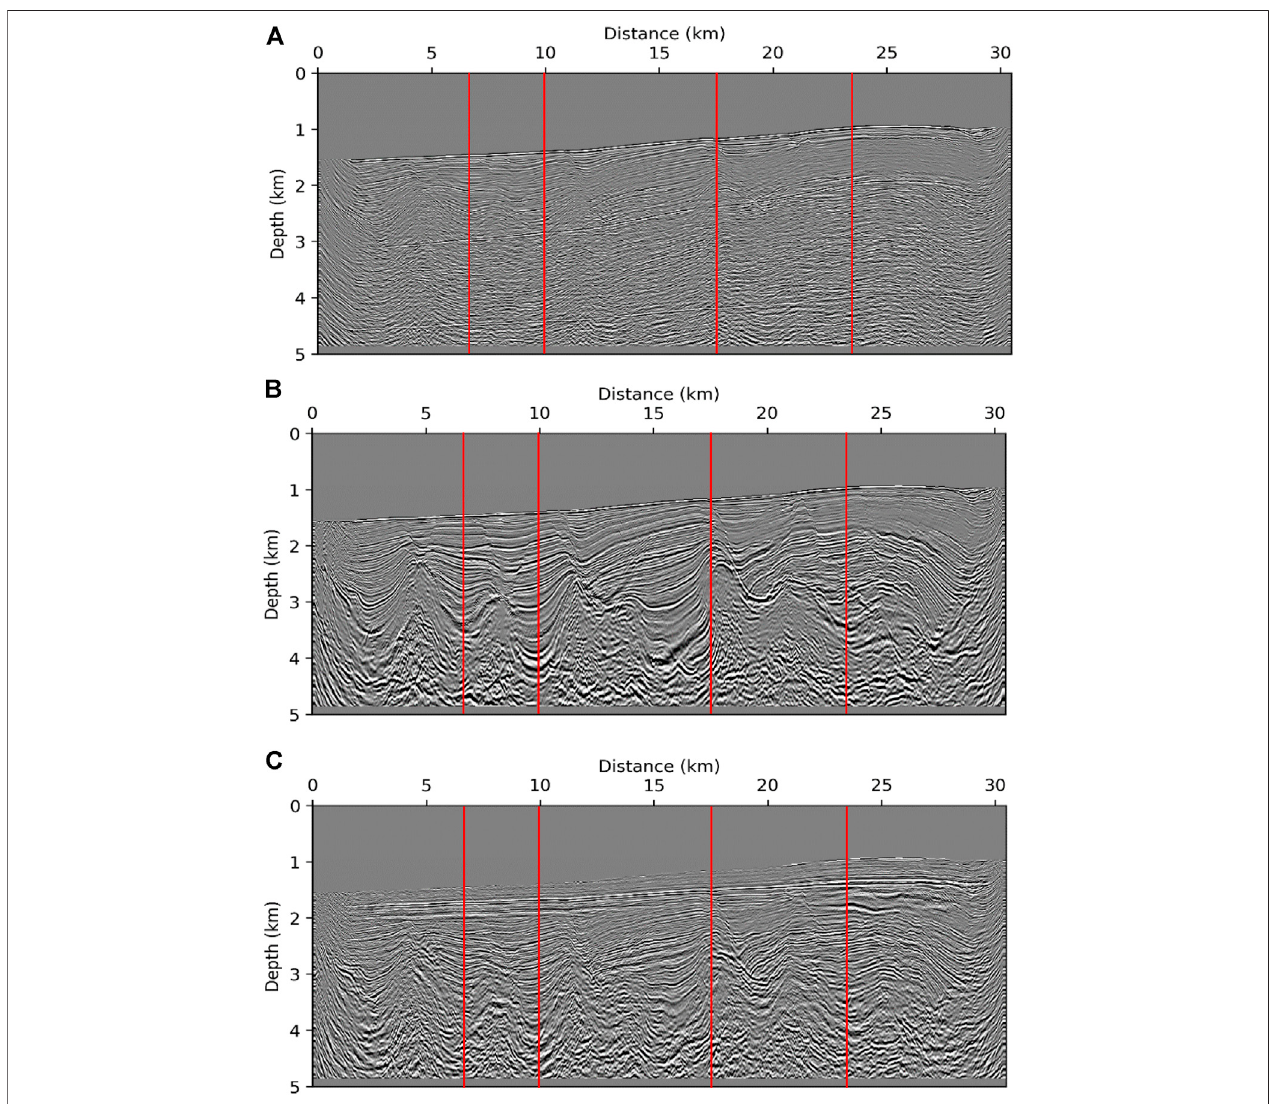
FIGURE 11 | RTM images from (A) homogeneous velocity model, (B) smoothed velocity inverted model by FWI, and (C) smoothed and 20% reduced velocity except sea water velocity model from (B) . Four red lines in each RTM images are locations for extracting FDCIGs and ODCIGs.